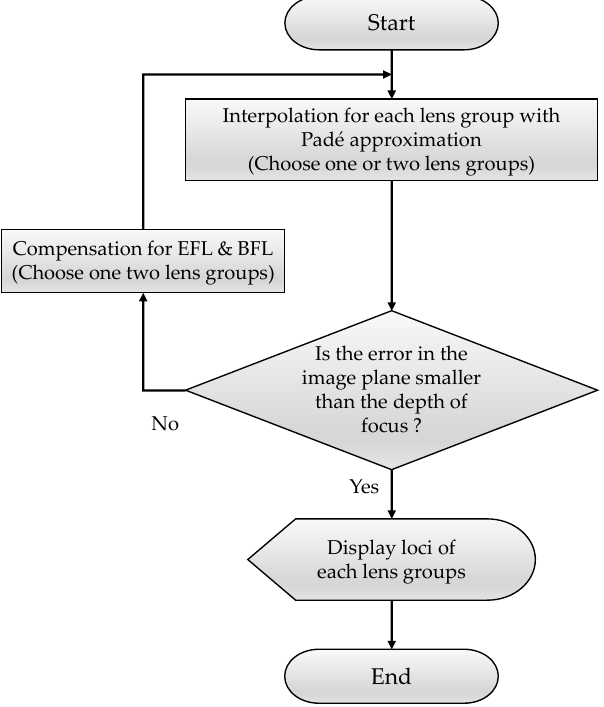
Figure 4. Flow chart for calculating zoom locus with Padé approximation.